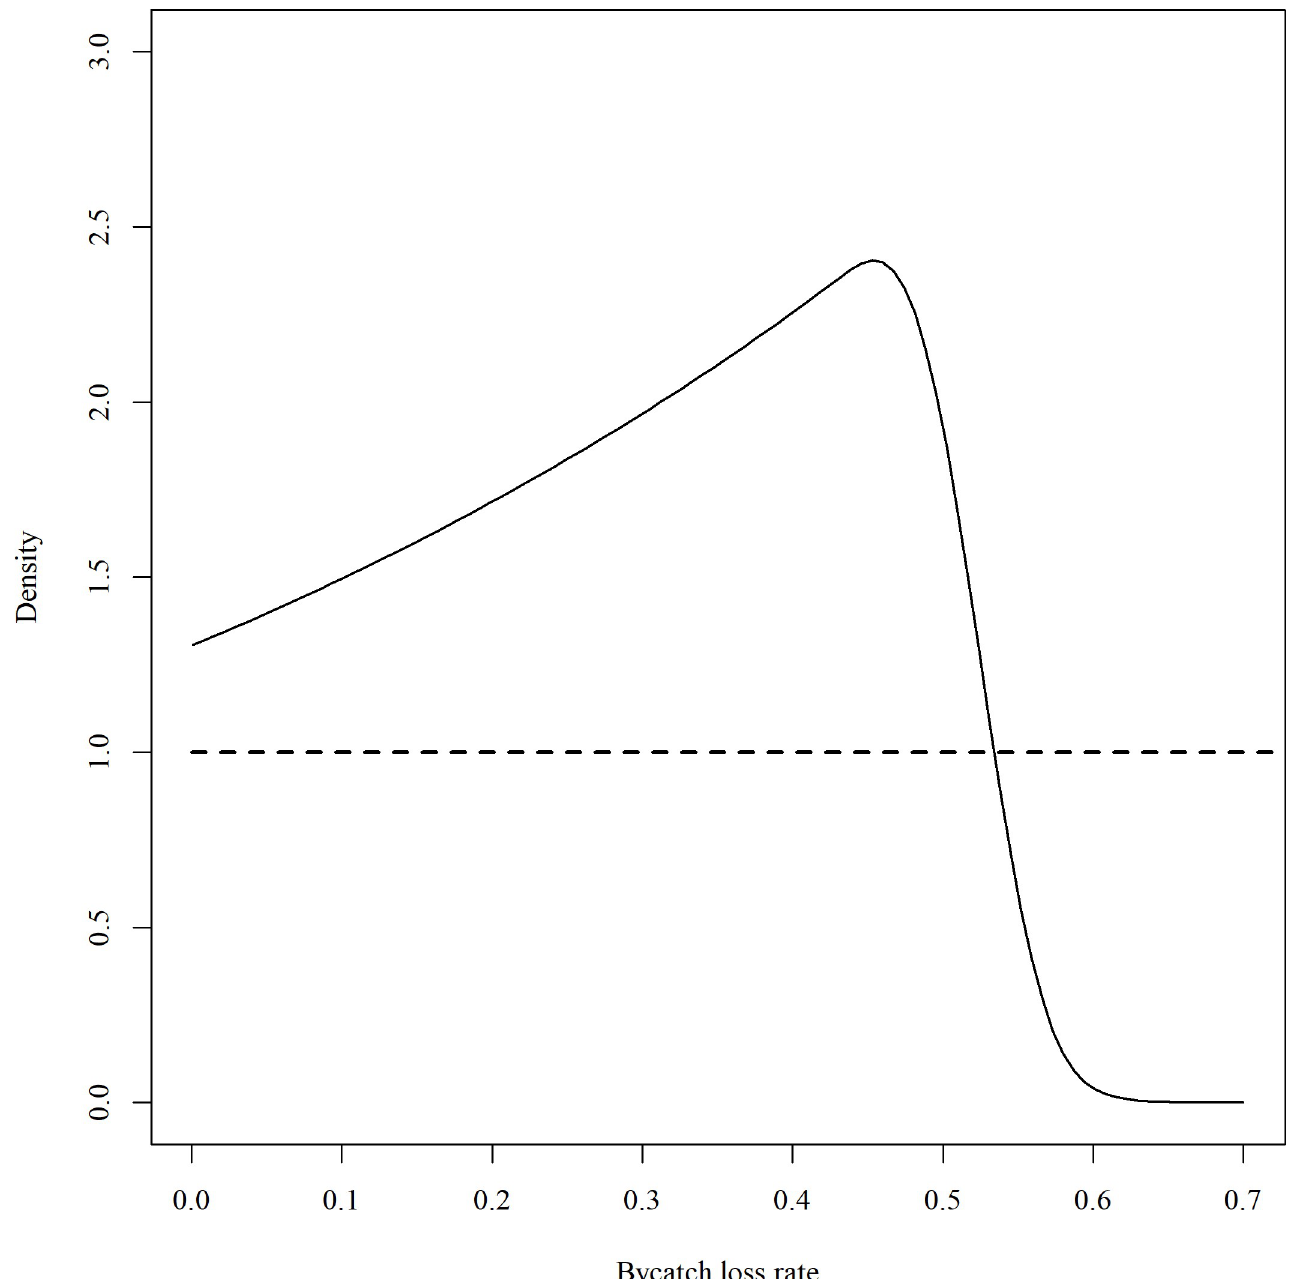
Fig 4. Prior (dashed line) and posterior (solid line) distributions of the bycatch loss rate ( p loss ). The prior is a uniform distribution from 0 to 1. Count data extracted from Brothers et al. [7] were used to estimate p loss .